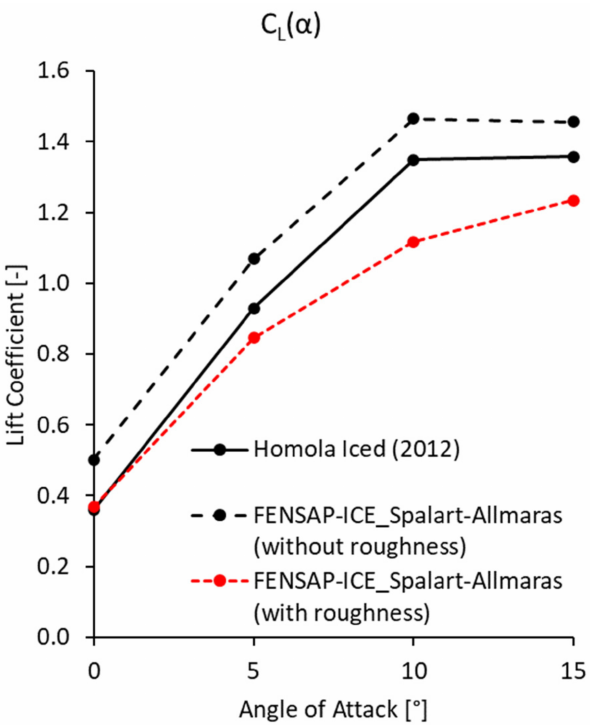
Figure 9. Lift coefficient for the iced airfoil estimated with and without roughness in comparison with [25].